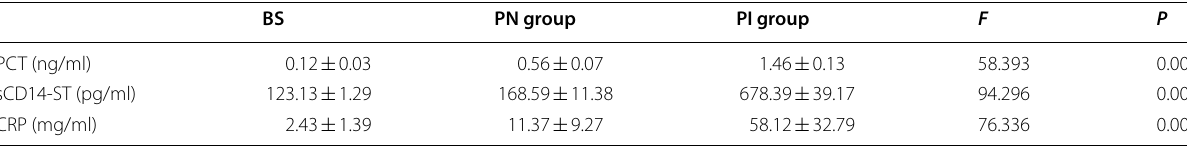
Table 3 Patient serum PCT, sCD14-ST, and CRP levels